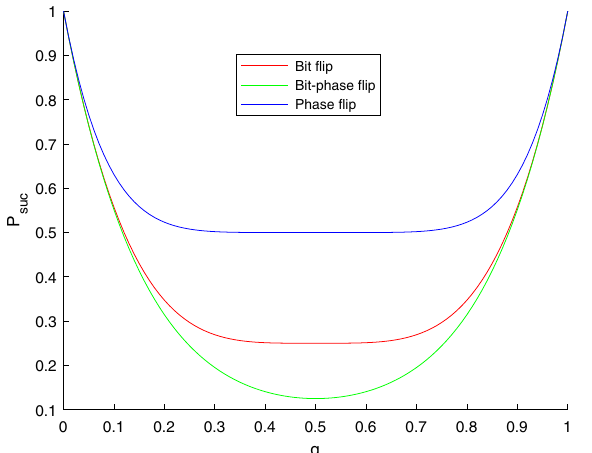
Figure 2. The variations of the success probabilities P suc using three kinds of flip channel with noise strength